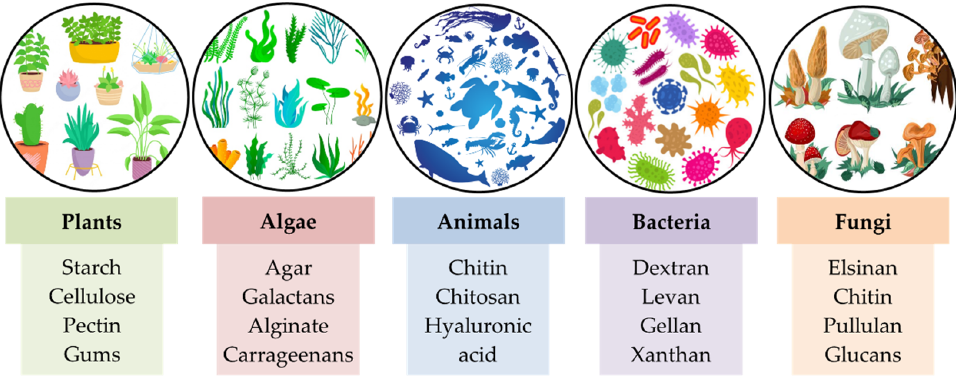
Figure 1. Natural polysaccharides classified according to their origin. Adapted from